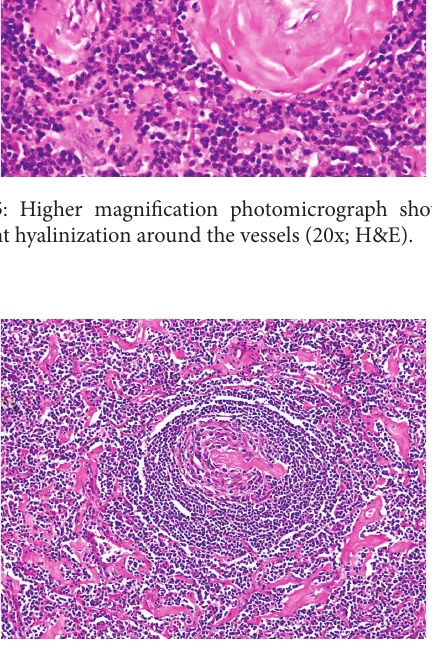
Figure 6: Prominent hyalinization around a vessel entering the germinal center with “onion-skinning” of the mantle zone (10x;